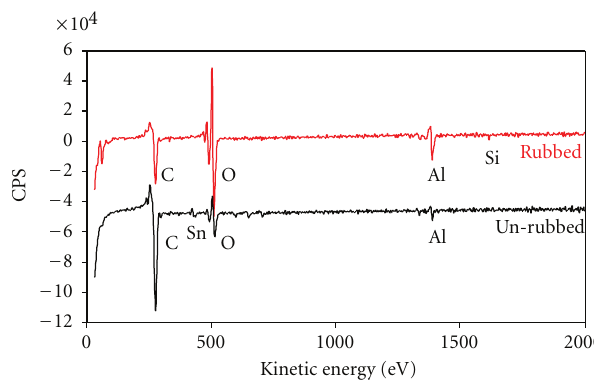
Figure 8: AES spectrum of rubbed surface (GMO in PAO for 120